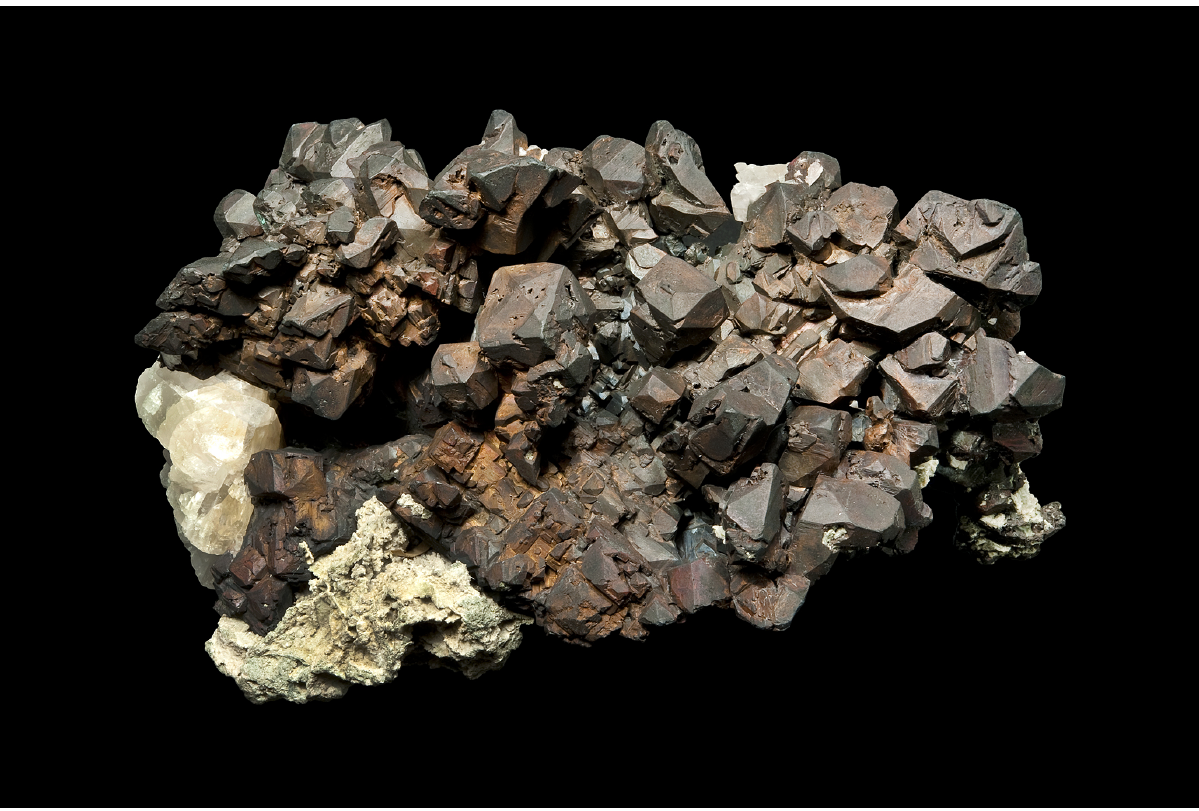
Figure 1. Michigan copper specimen from famous French collector Colonel Vésignié, inherited by the Sorbonne mineral collection in 1954 (specimen size: 17 × 10 . 5cm). This spectacular sample shows some more or less deformed { 410 } tetrahexahedral crystals. Photo: Alain Jeanne-Michaud.